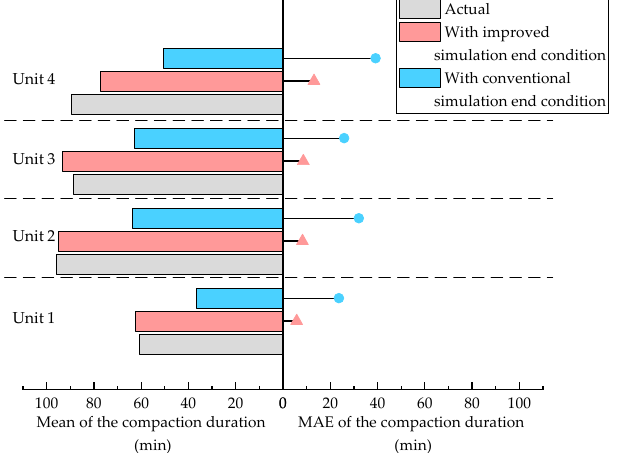
Figure 11. Comparison of the Mean and MAE of the compaction duration of each unit under different simulation end conditions.